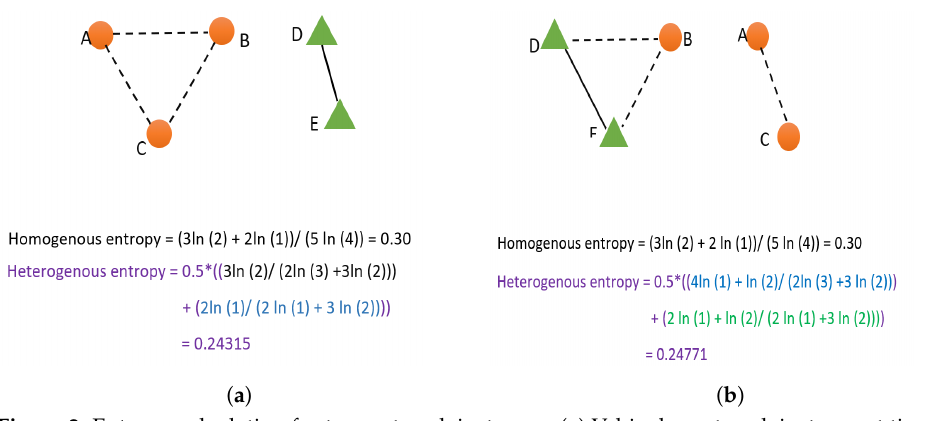
Figure 2. Entropy calculation for two network instances. ( a ) Vehicular network instance at time t − 1; ( b ) Vehicular network instance at time